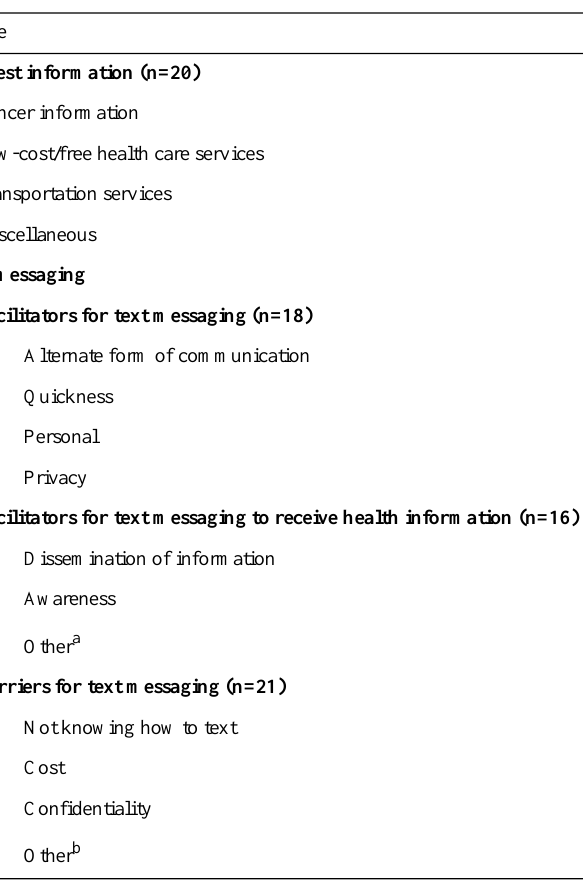
Table 2. Focus group